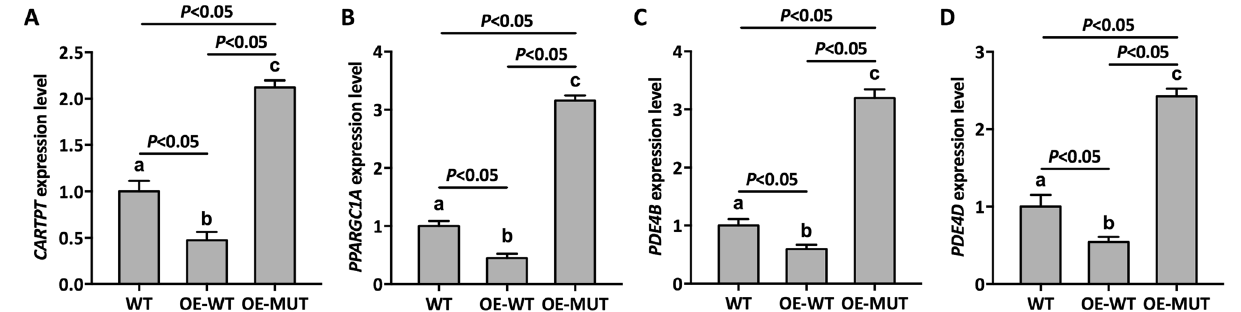
Figure 4. Relative expression level of NR0B1 -associated genes in transfected and non-transfected cells. ( A ) CARTPT , ( B ) PPARGC1A , ( C ) PDE4B , and ( D ) PDE4D . WT: Wild-type cells, OE-WT: Cells overexpressing normal NR0B1 , OE-MUT: Cells overexpressing variant NR0B1 . Error bars represent the standard deviation from triplicate samples. Different lowercase letters represent the significance of differences at P < 0.05.